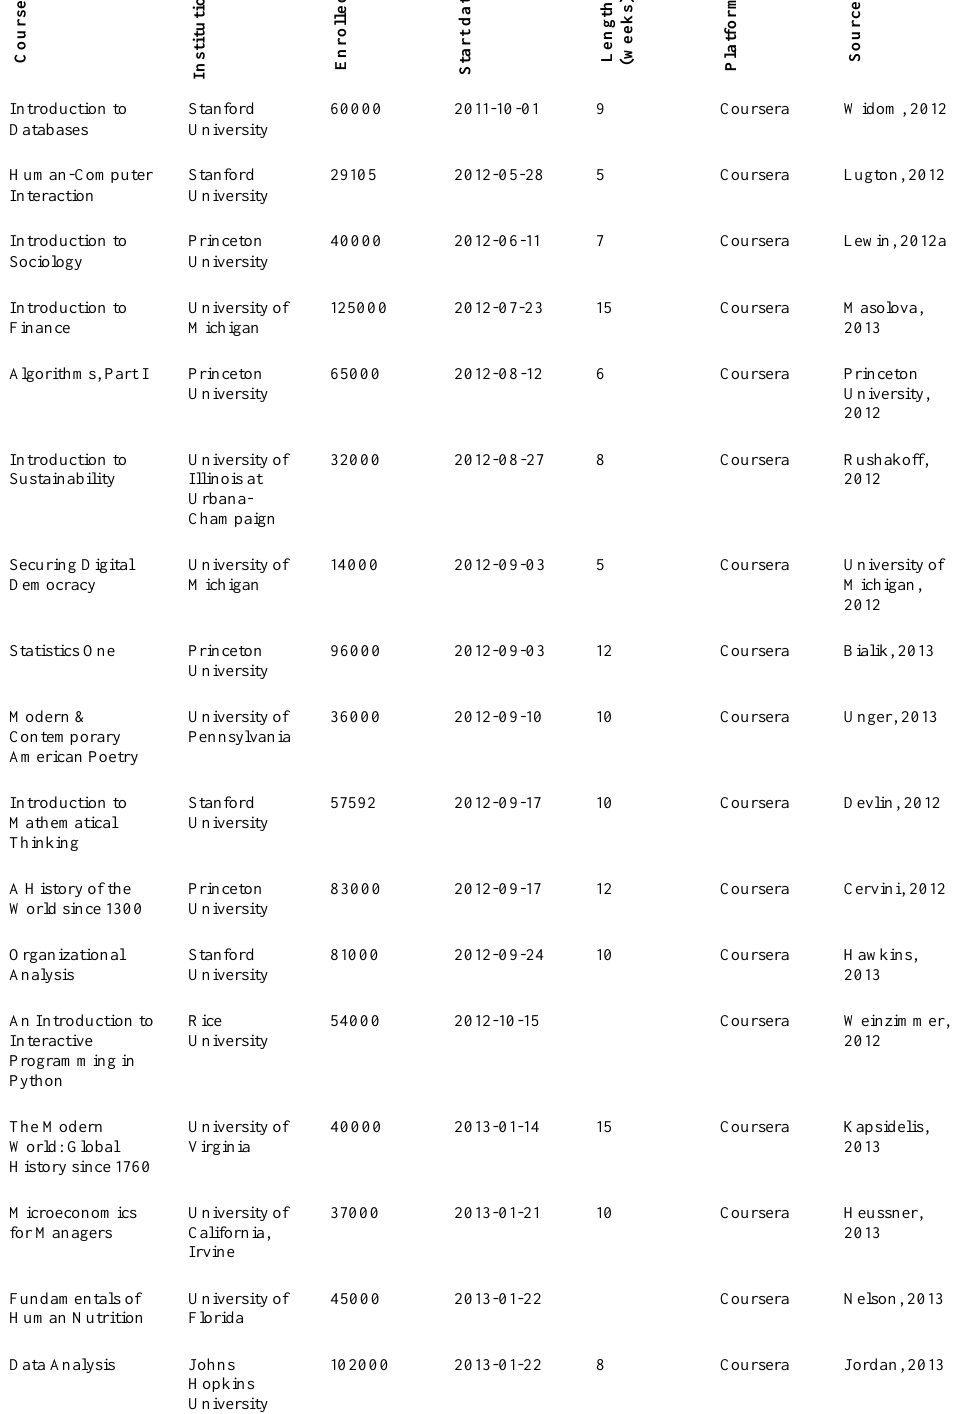
Table 1: Data Drawn from Online Sources for Courses for which Enrolment Numbers Only were